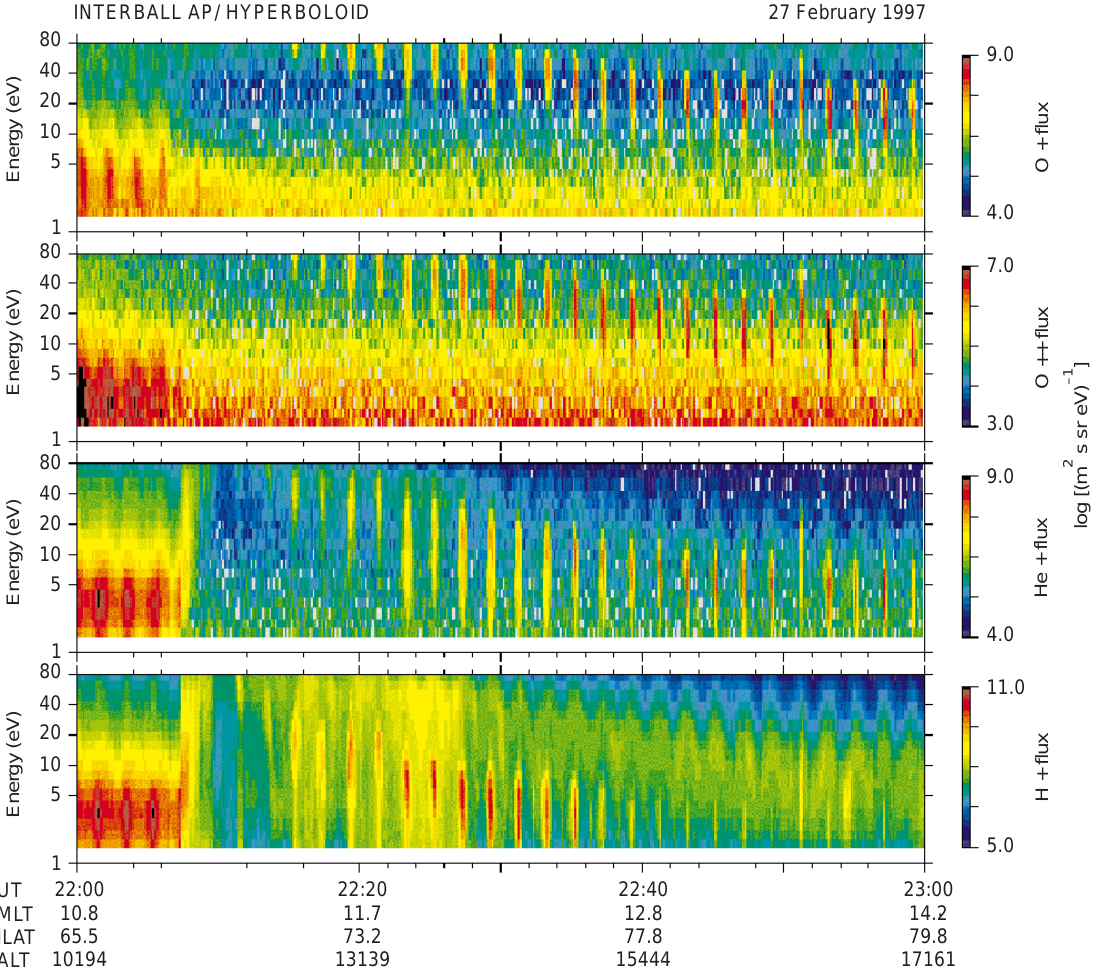
Fig. 9. Energy-time spectrograms for low-energy ions measured by Hyperboloid, during a cusp/cleft crossing on 27 February 1997. From top to bottom, O + , O ++ , He + , and H + fluxes averaged over Hyperboloid half-planar field of view